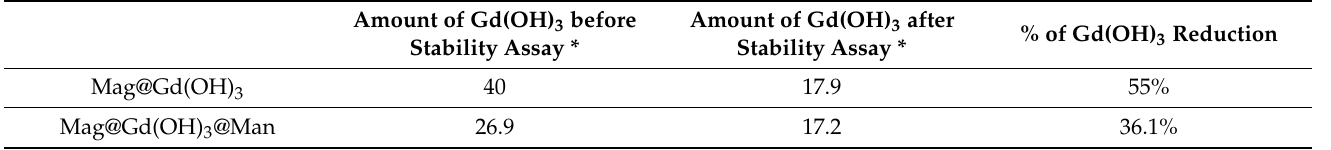
Table 2. Reduction in gadolinium phase, expressed as mg Gd(OH) 3 /100 mg of the sample,